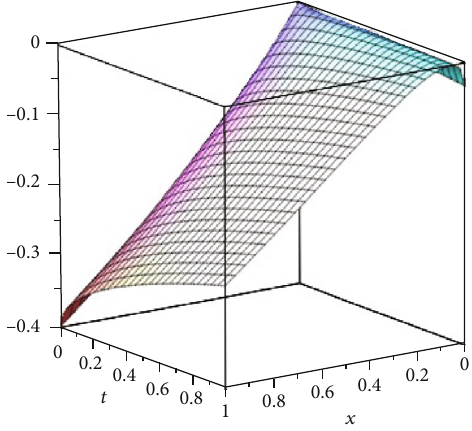
ð x , t Þ of Equation (45). 2,3